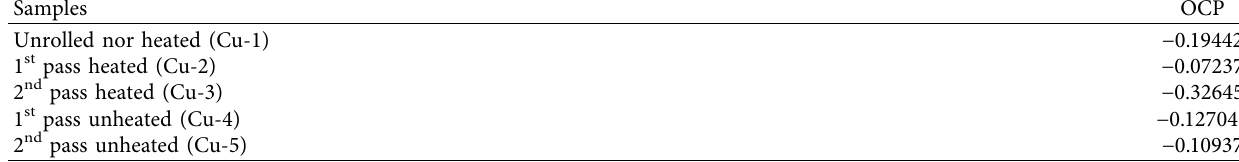
Table 9: Open circuit potential (OCP) values of copper samples during ARB and the parent sample.